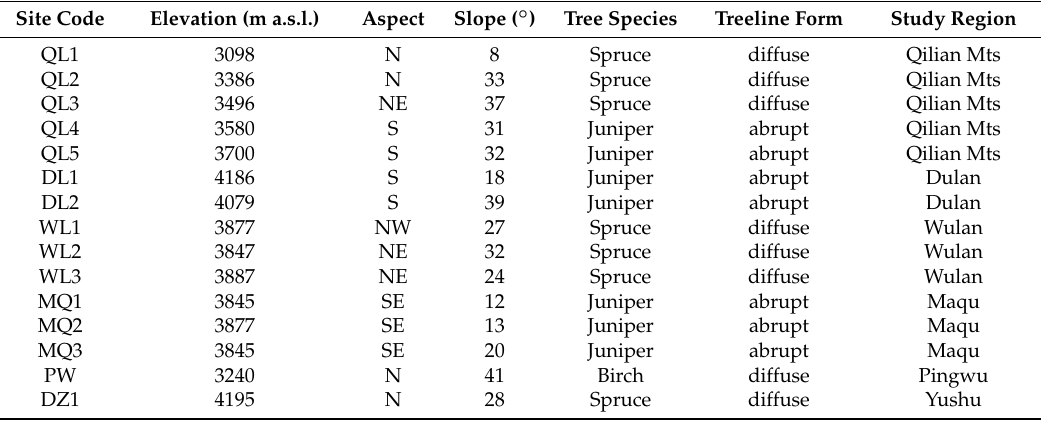
Table A1. Basic information for the treeline sites located in the Tibetan